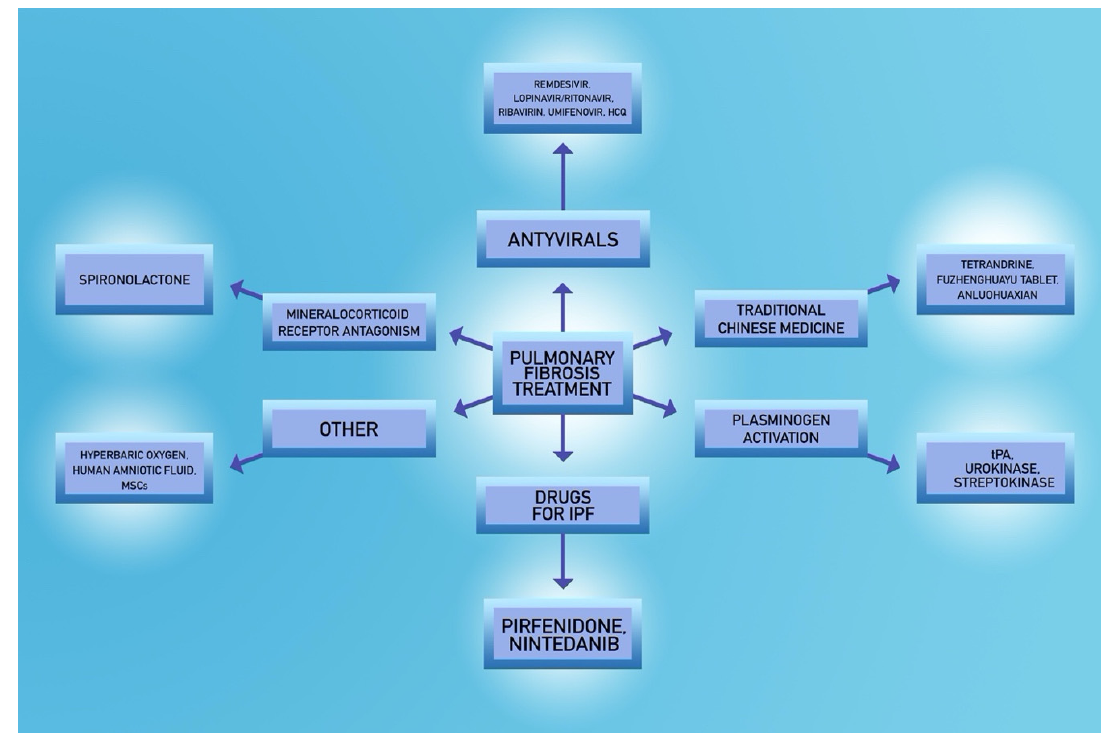
Figure 3. Suggested treatment options for pulmonary fibrosis in COVID-19.